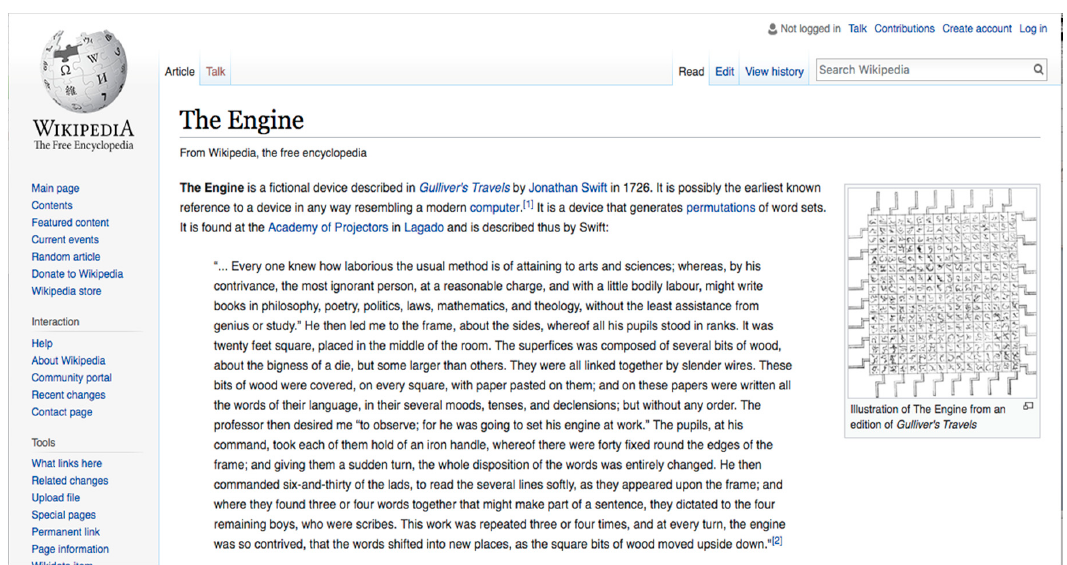
Figure 2. Screenshot of The Engine. Wikipedia: The Free Encyclopedia . San Francisco: Wikimedia Foundation, Inc. 12 May 2016.